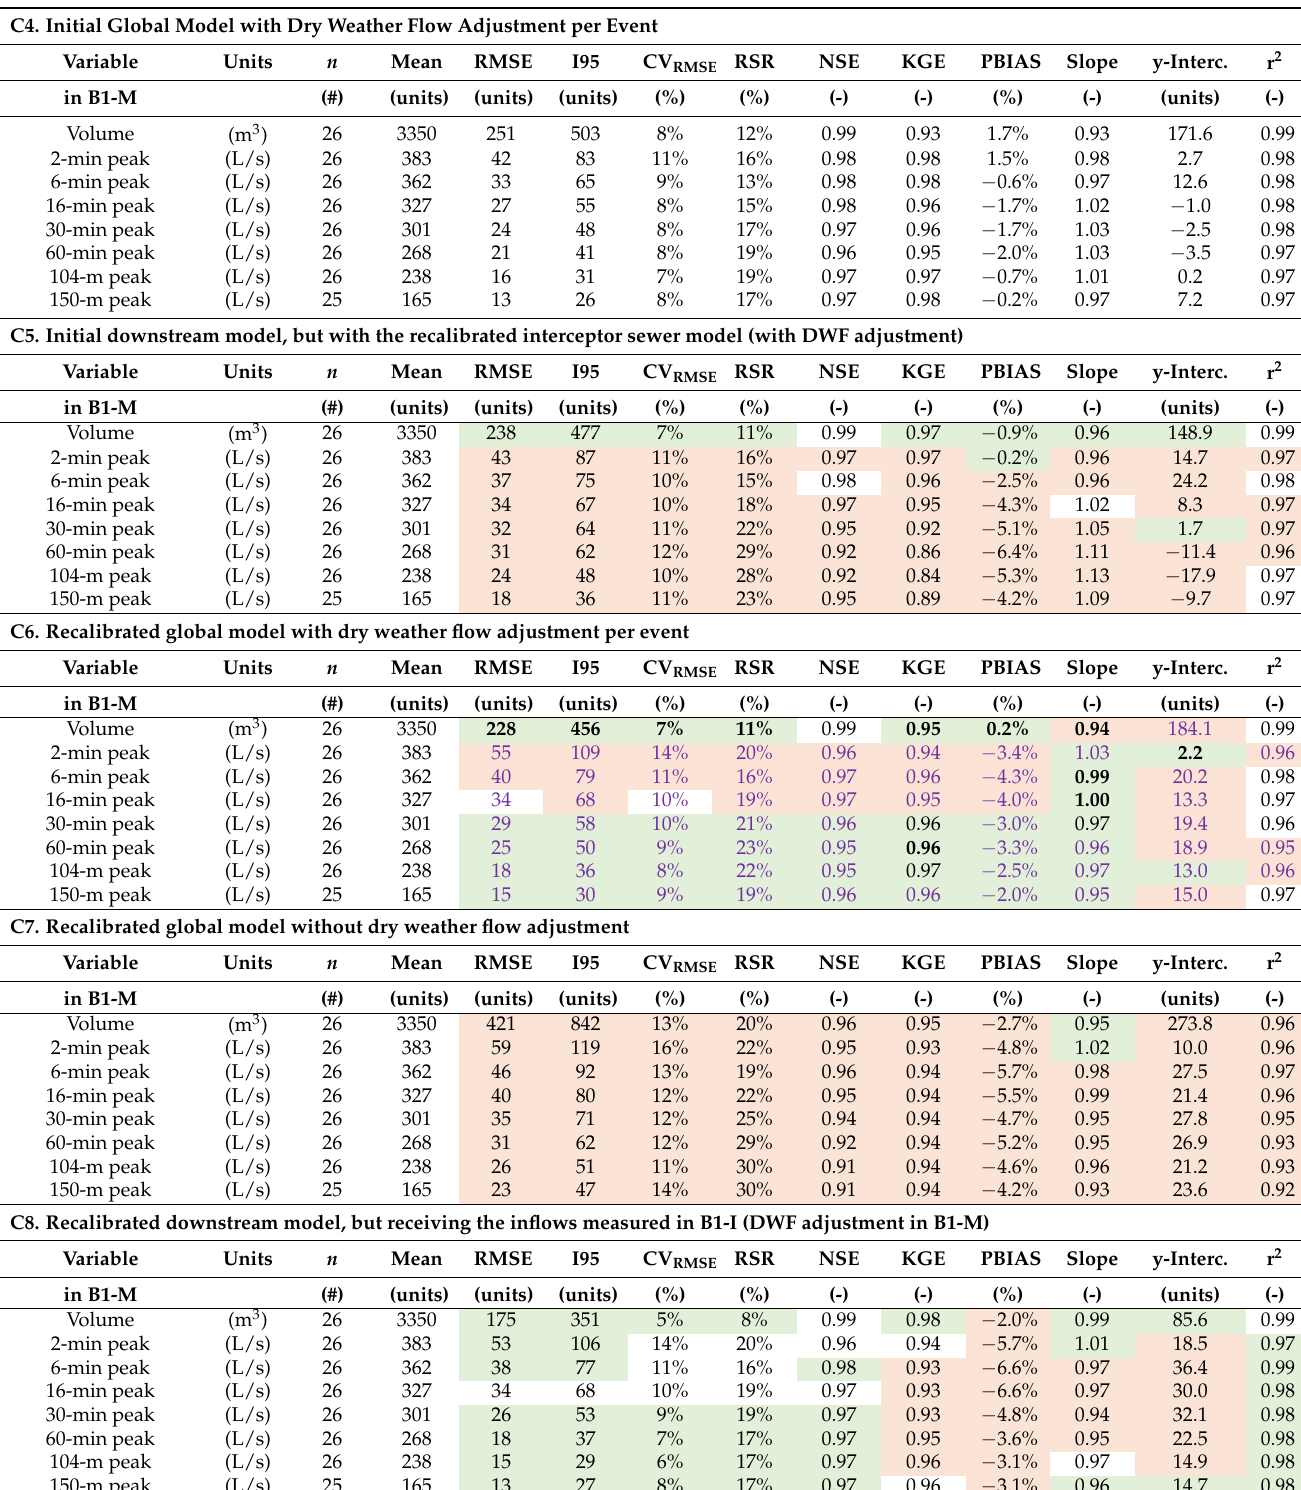
Table 5. Statistical results in the downstream monitoring section